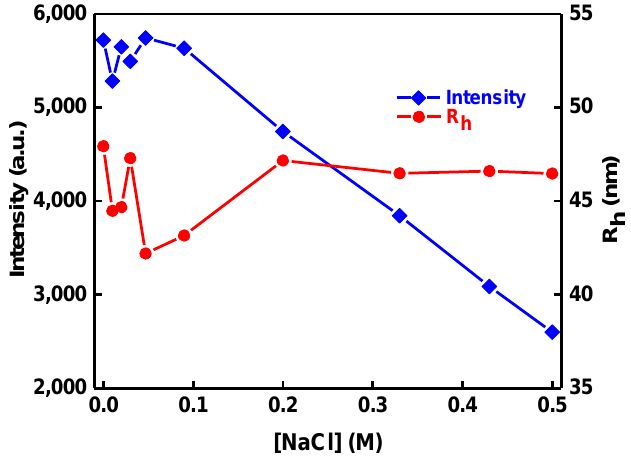
Figure 9. R h and scattered intensity as a function of ionic strength ([NaCl]) for PLMA 22 - b -POEGMA 58 /10% NPs/20% IND mixed aqueous solution.